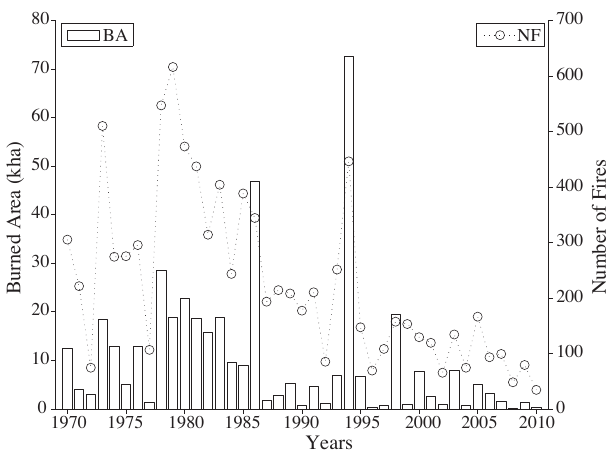
Fig. 3. Total annual burned area (BA) and number of fires (NF) with area larger than 0.5ha in eastern Catalonia. Table 1. Trends for annual BA and NF, over the period 1970– 2010 for eastern Catalonia and over 1983–2010 for all Catalonia. Units are trenddecade − 1 . The trend significance is assessed by the Monte-Carlo test implemented by Turco and Llasat (2011). Domain